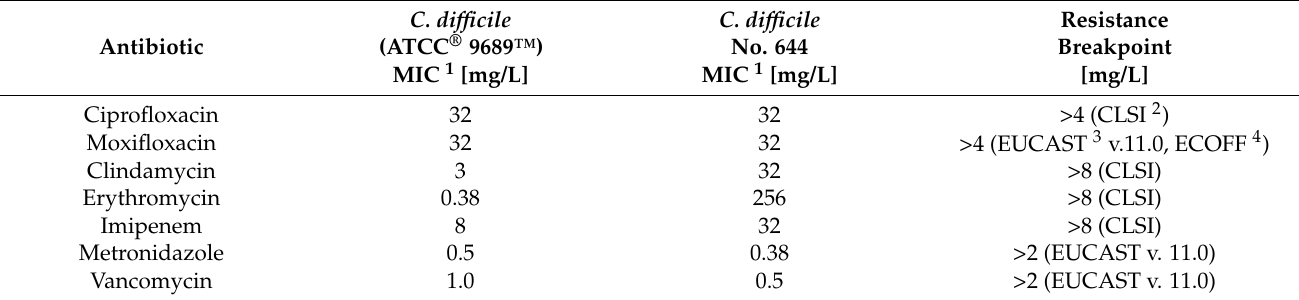
Table 3. Antimicrobial susceptibility of C. difficile strains determined by using the gradient diffusion method ETEST ® . Antibiotic